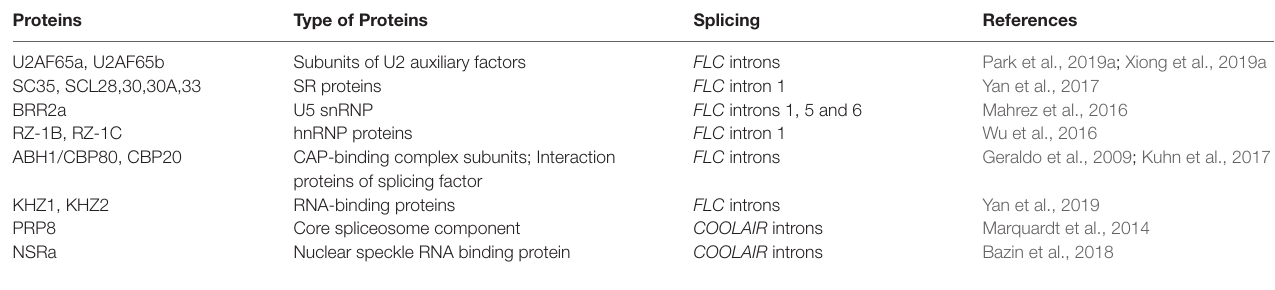
TABLe 1 | Proteins involved in pre-mRNA splicing of FLC and COOLAIR